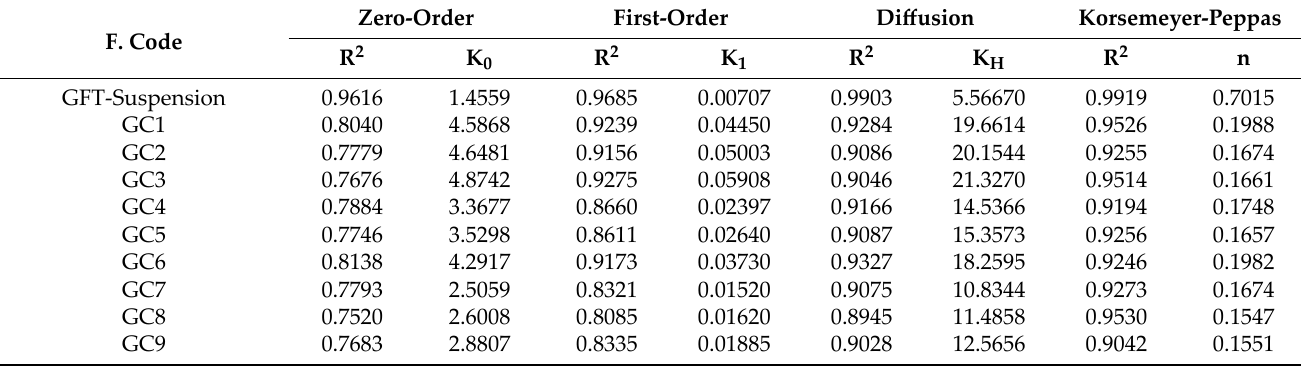
Table 3. Kinetic analysis of the fabricated GFT‑CNP